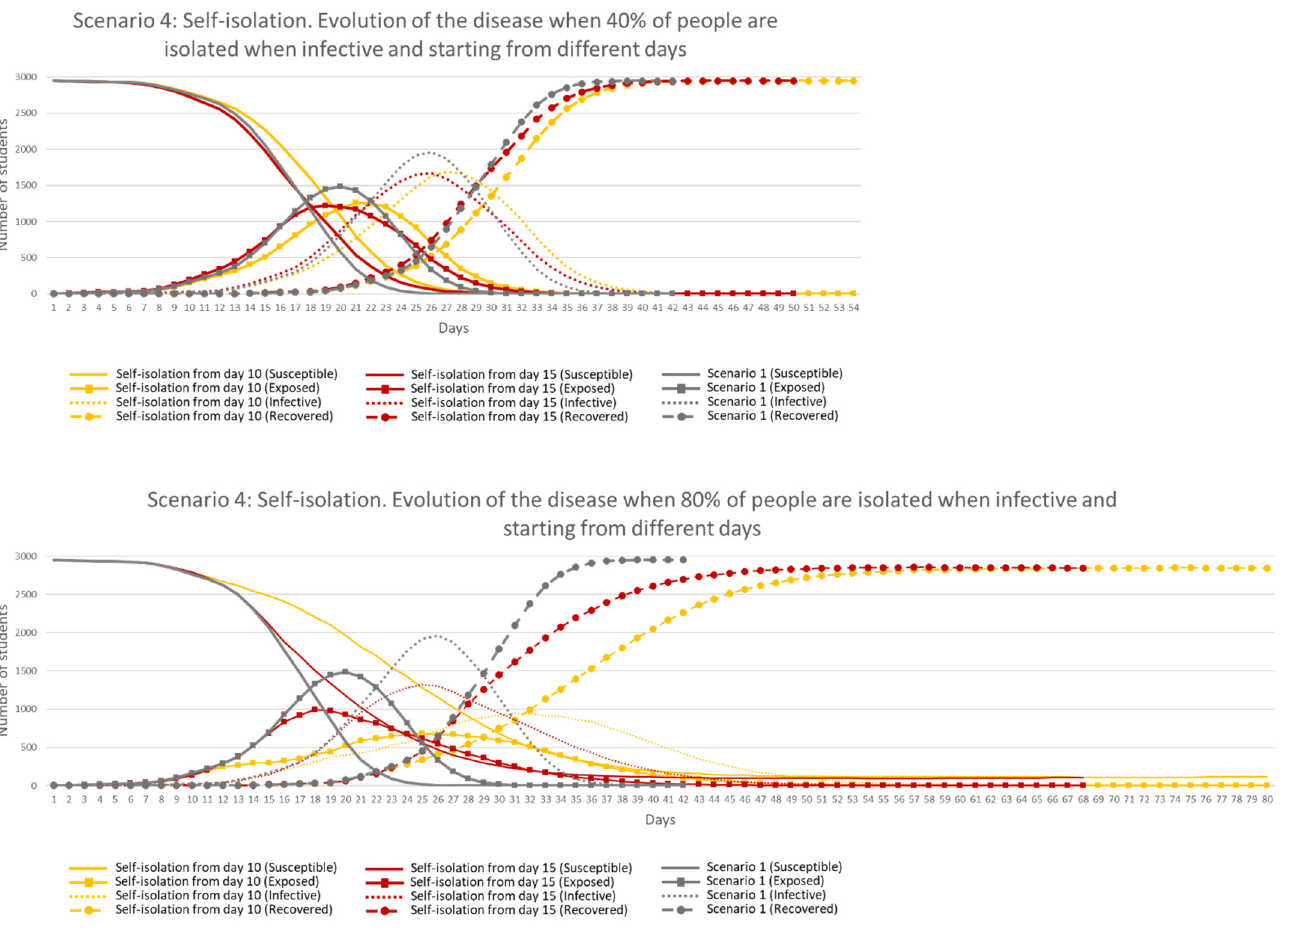
Figure 17. Epidemic evolution for Scenario 4 ‘self-isolation’ when 40% (top chart) and 80% (bottom) of agents were self-isolated from different days. Full results for this scenario are available in Appendix F.